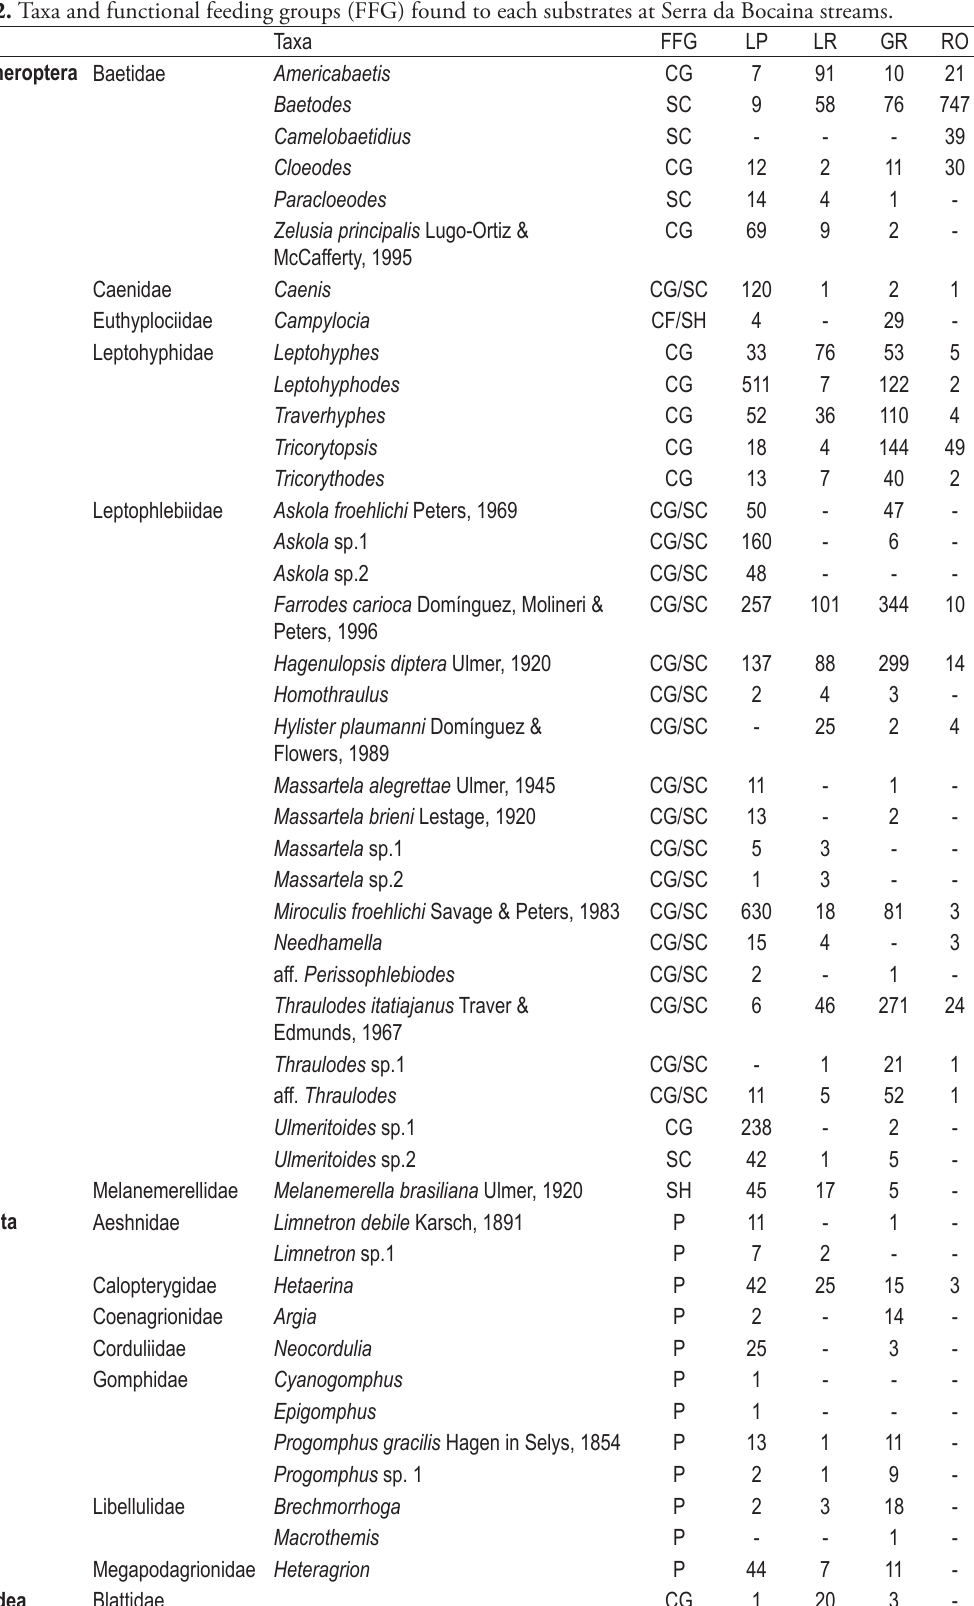
LP = litter from pool, LR = litter from riffle, GR = gravel and RO = rocks. CG = collector-gatherers, CF = collector- filterers, SC = scrapers, SH = shredders, P =